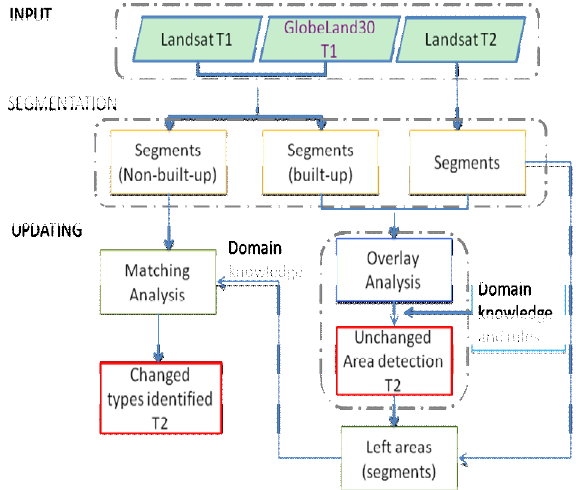
Figure 1. Globeland30 updating procedure in this study